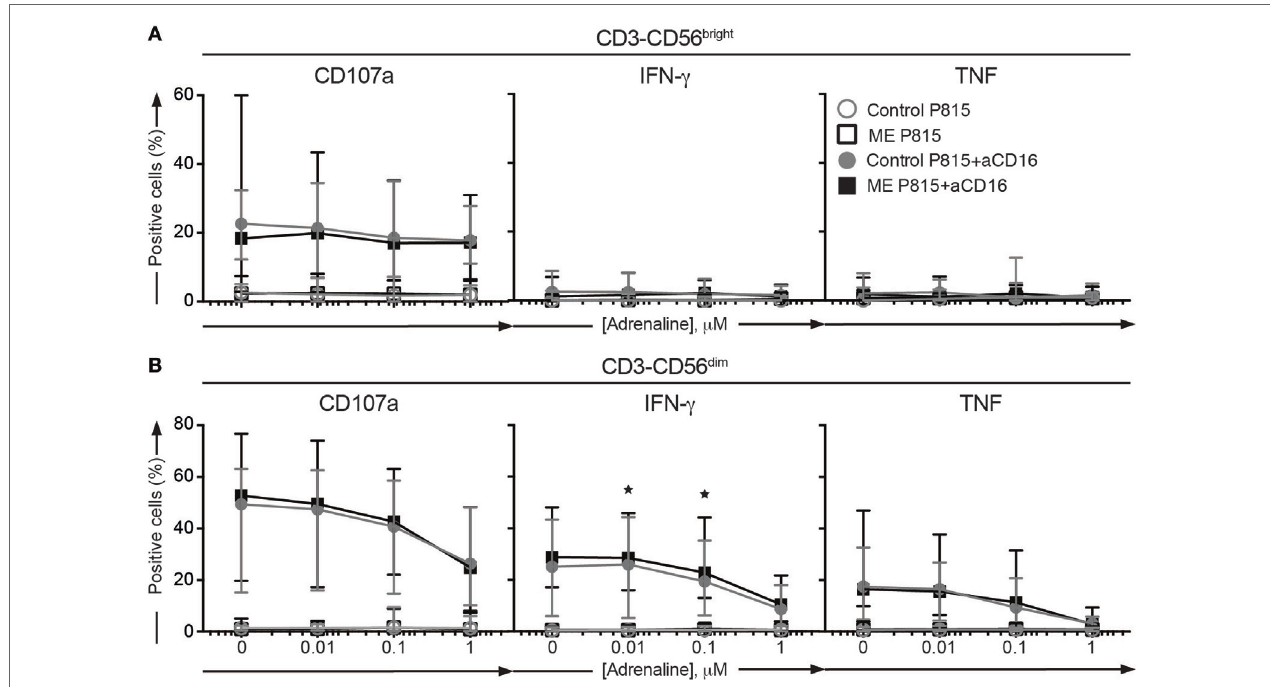
FigUre 5 | Adrenaline inhibition is not significantly different between ME/CFS patients and controls. (a,b) Analysis of exocytosis, IFN- γ , and TNF production after inhibition with adrenaline in the Stockholm substudy. Peripheral blood mononuclear cells were thawed, rested overnight, preincubated for 30 min without or with adrenaline at three concentrations and then stimulated for 4 h with P815 or P815 + anti-CD16, and subsequently stained with antibodies to CD107a in combination with lineage markers, fixed, permeabilized, and stained intracellularly for IFN- γ and TNF. (a) Percentage of CD3 − CD56 bright natural killer (NK) cells positive for CD107a, IFN- γ , or TNF. (b) Percentage of CD3 − CD56 dim NK cells positive for CD107a, IFN- γ , or TNF. 24 patients and 28 controls from the Stockholm substudy are included in the